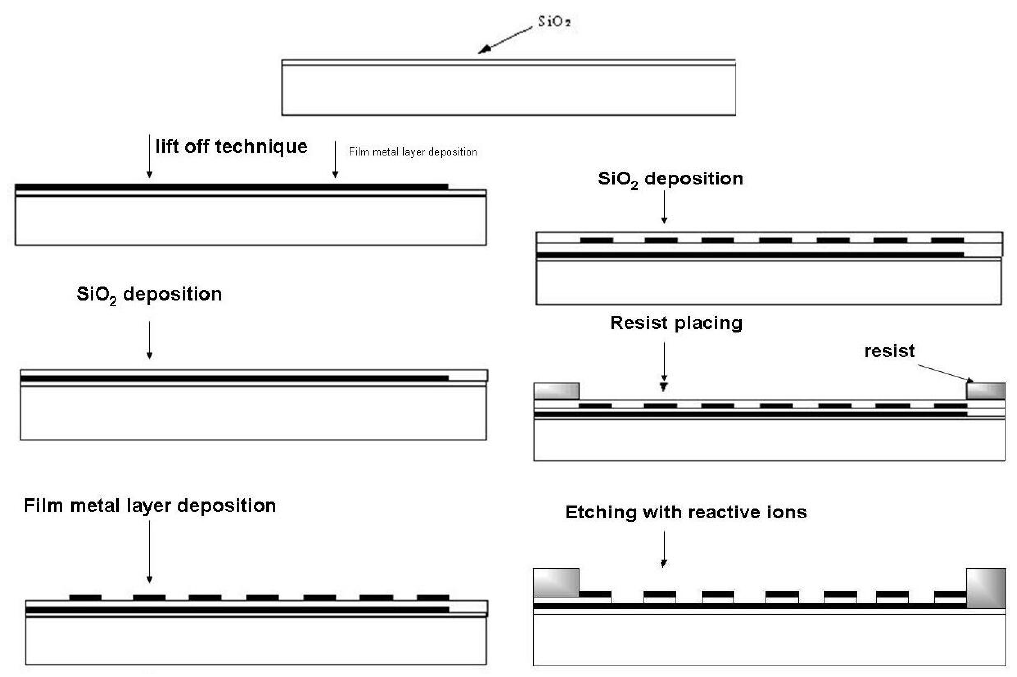
Figure 8. Scheme of vertically separated IDA array photolitographic